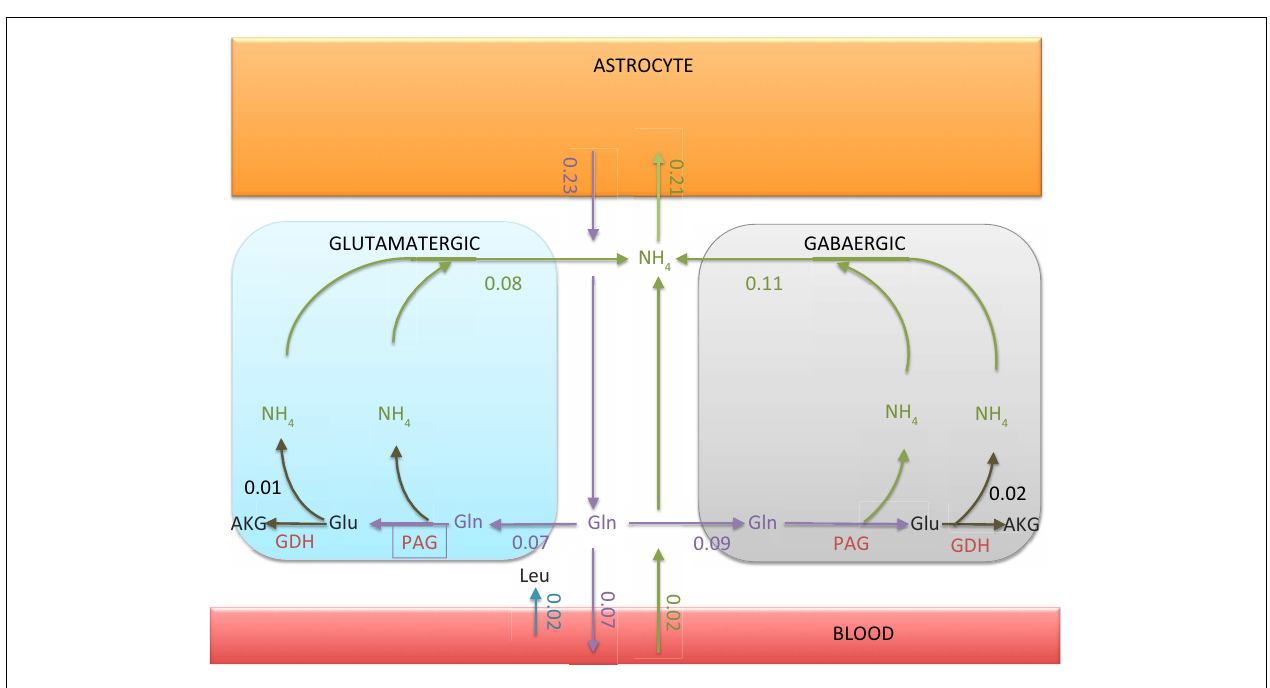
glutamine efflux.The imbalance, however, is compensated by the influx of leucine from blood to ECS, as indicated in the figure.The net influx of NH + carried by leucine into astrocyte turns out to be exactly 4 0.02 µ